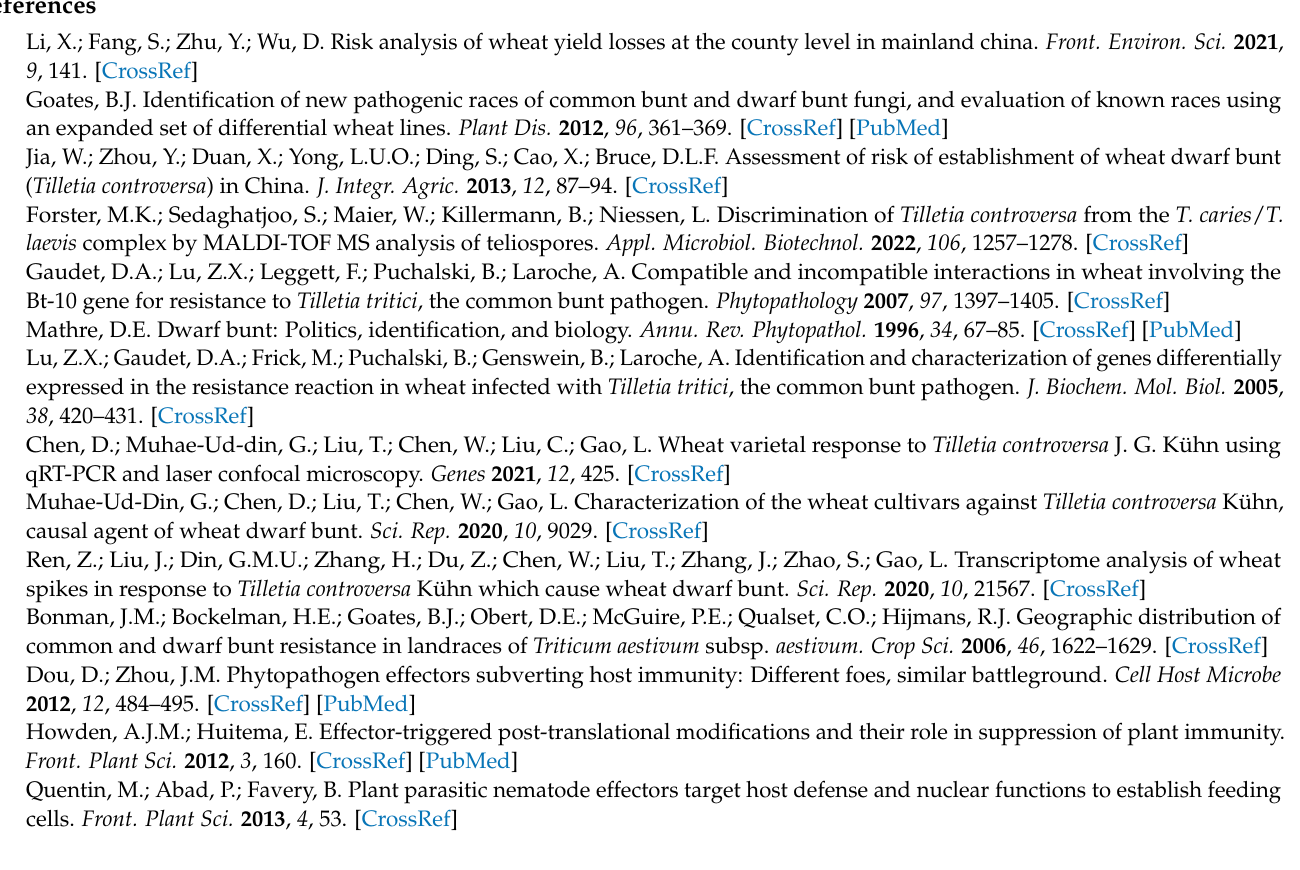
Table S3. List of DEPs related to wheat defense against T. foetida infection. Figure S1: The schematic diagram explaining the iTRaq labeling and the downstream proteomic processes of this study; Figure S2: The image of the wheat spikes infected with fungi used for the study (a, control; b infected with T. controversa ; c, control, d, infected with T. foetida